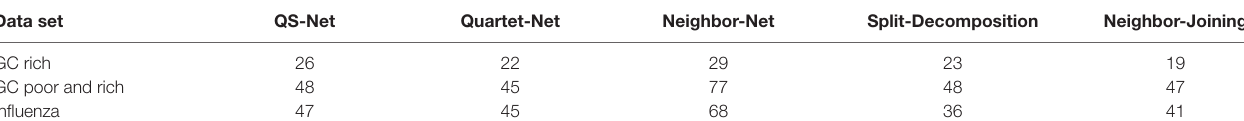
TABLE 5 | The number of full splits reconstructed by five methods on bacterial data set and the influenza data set.